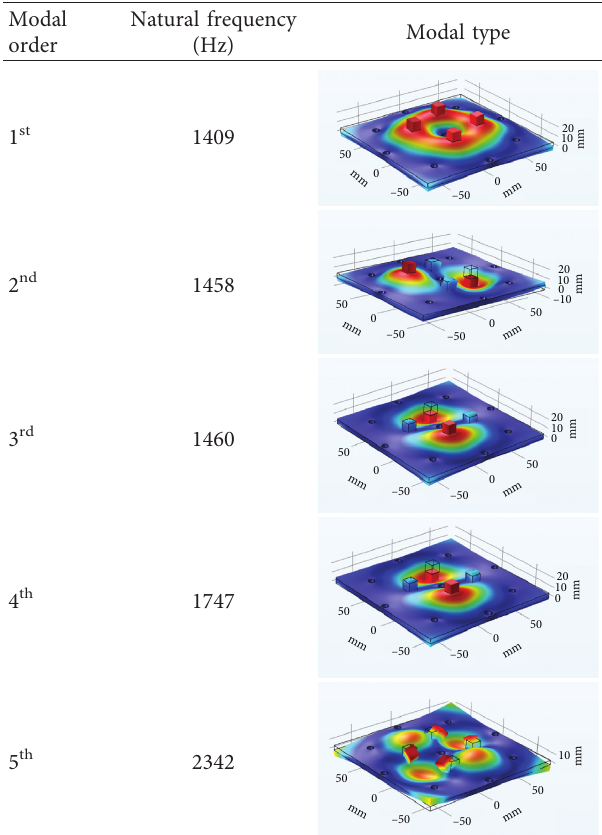
Table 4: Natural frequencies and modals of the PCB (including